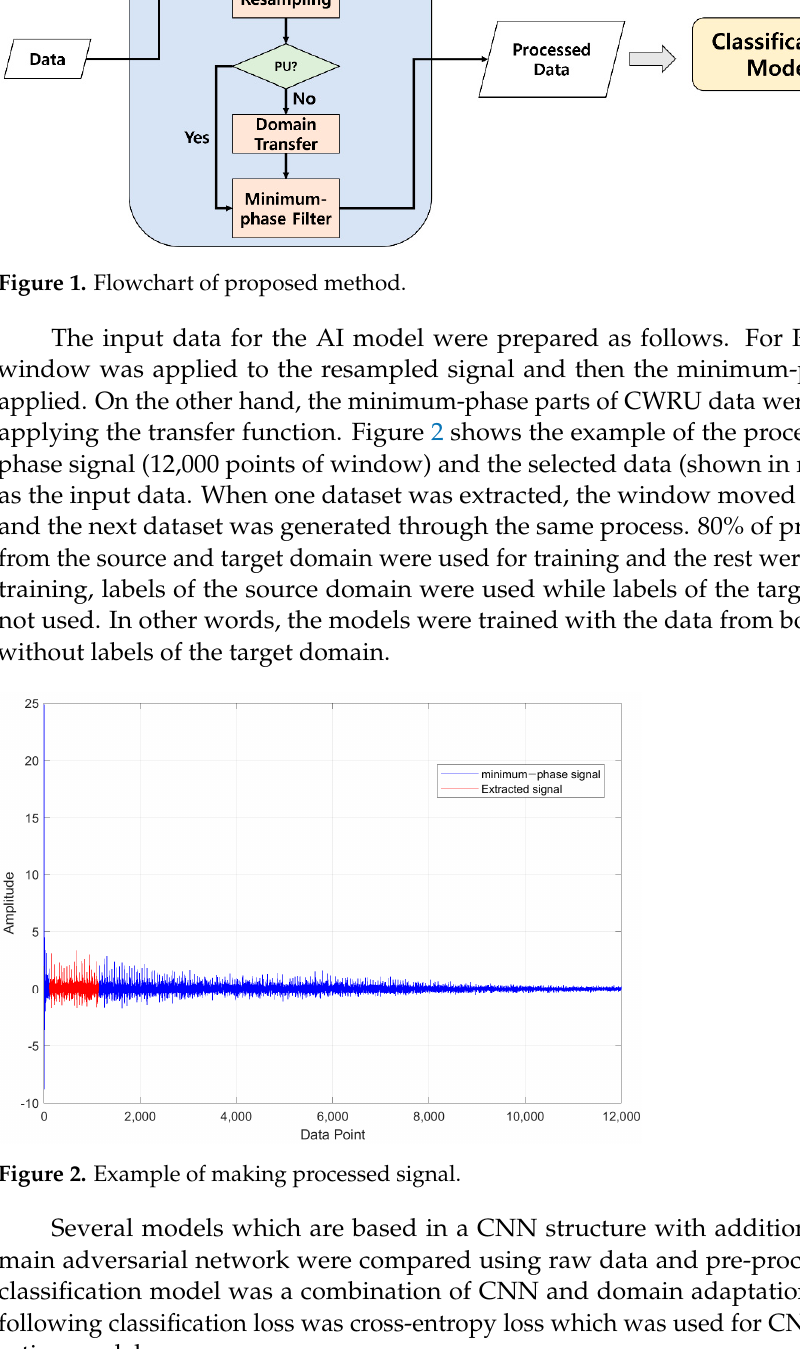
Figure 2. Example of making processed signal.